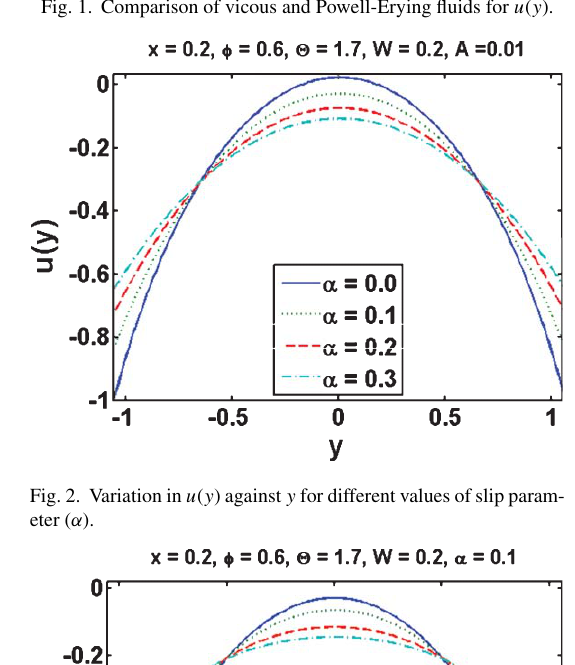
Fig. 1. Comparison of vicous and Powell-Erying fluids for u ( y ).